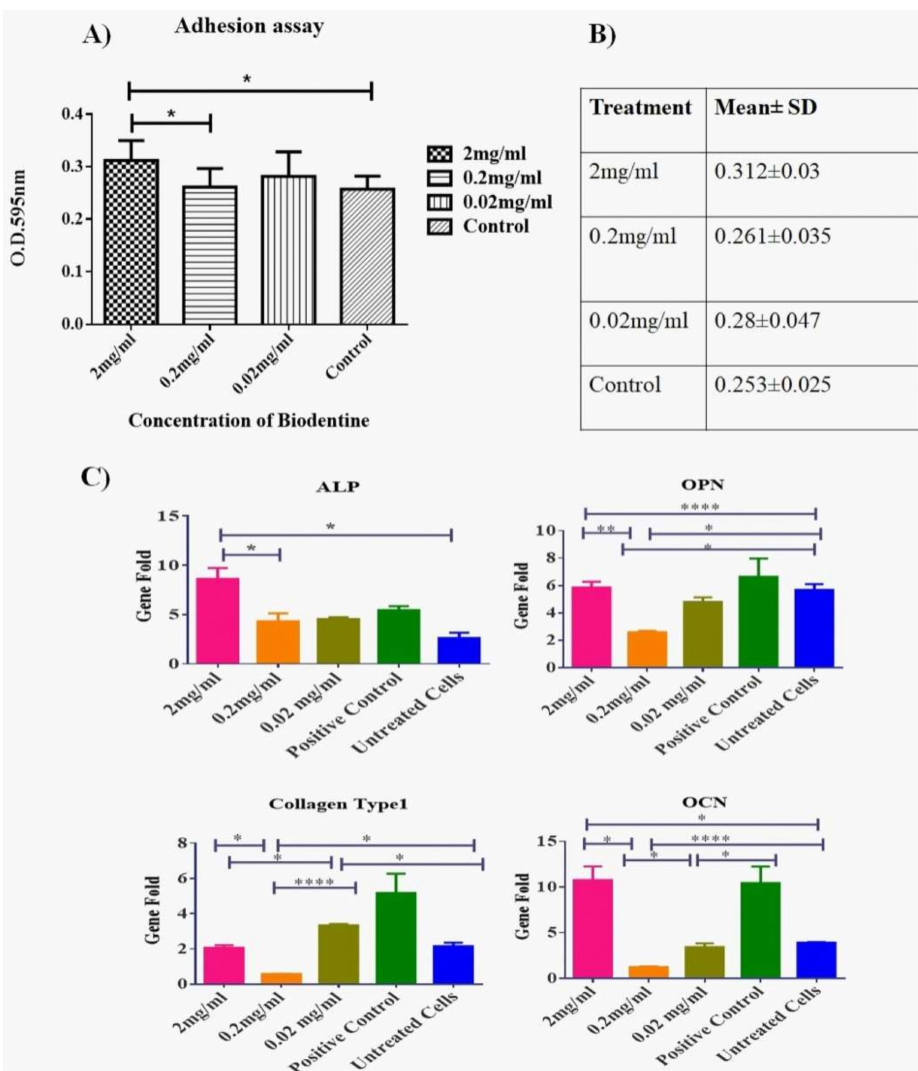
Figure 4. E ff ect of Biodentine ™ on the adhesion and mineralization potential of hPDLSCs treated with Biodentine ™ . ( A ) A statistical analysis of the number of the adherent hPDLSCs treated with di ff erent concentrations of Biodentine ™ (2, 0.2, 0.02 mg / mL) and blank control. A significant di ff erence in the numberofadherentcellswasobservedamongthedi ff erenttreatedgroupsP( < 0.05). ( B )Arepresentative table of the mean ± SD of adherent cells among all treated groups ( C ) The expression levels of osteogenic markers; ALP, OCN, OPN and Collagen type 1 of Biodentine ™ treated and control groups. (**** p < 0.00005, *** p < 0.0005, ** p < 0.005, * p <